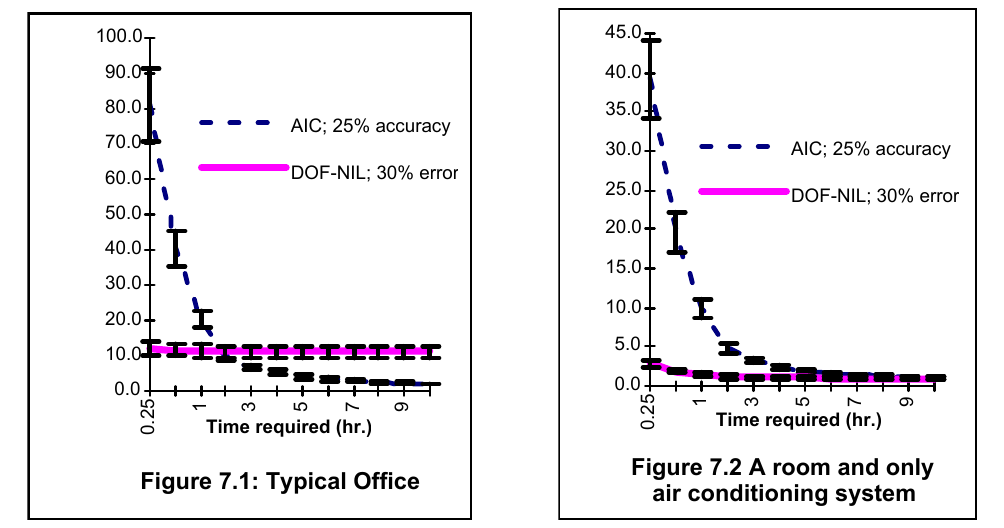
Figure 7: Additional Negative-Ions for 1 to 10 hours